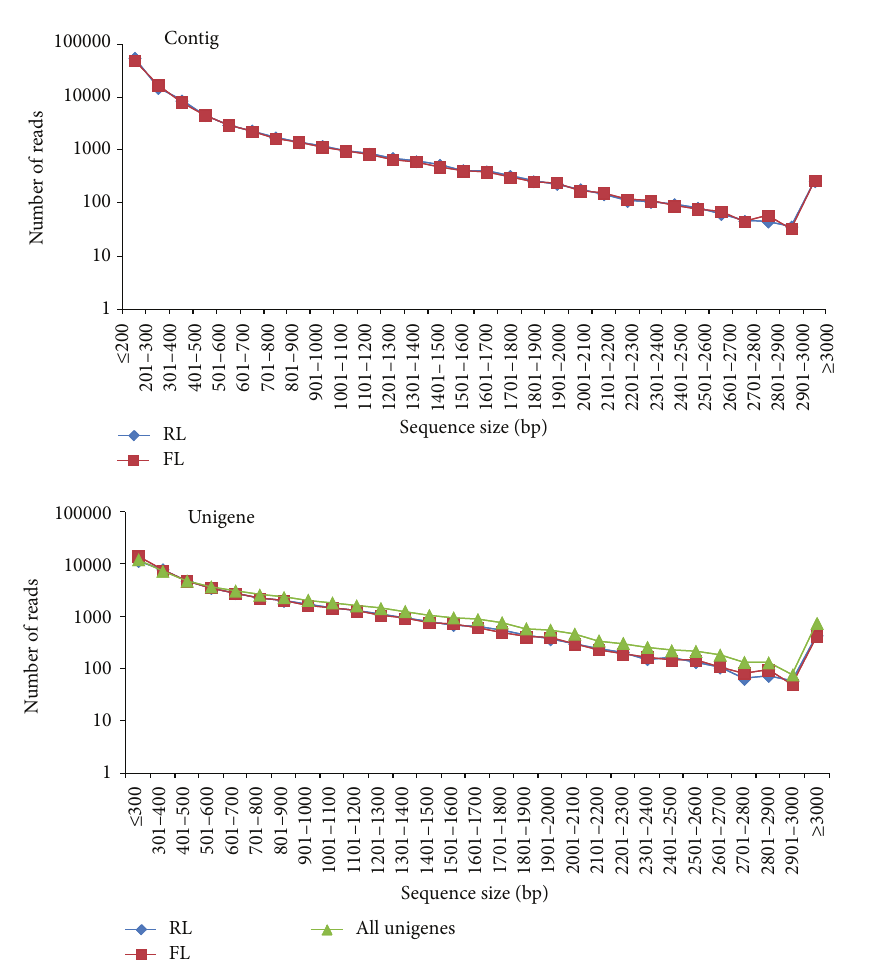
Figure 1: Size distribution of the assembled contigs and unigenes in RL and FL